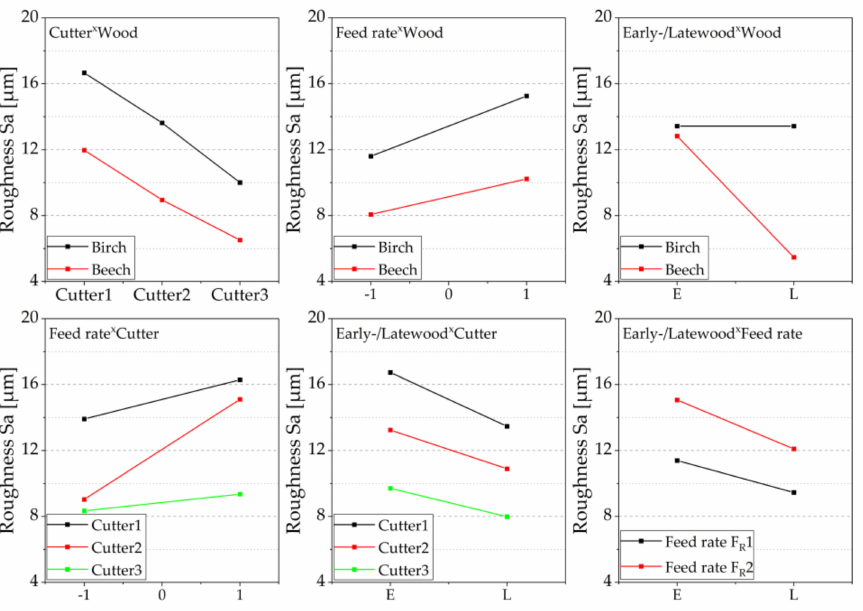
Figure 11. 2-way interactions of the roughness for different cutting combinations, mean values of the factors are shown, and interactions are visualized based on the courses of the effect lines; please see explanatory Figure